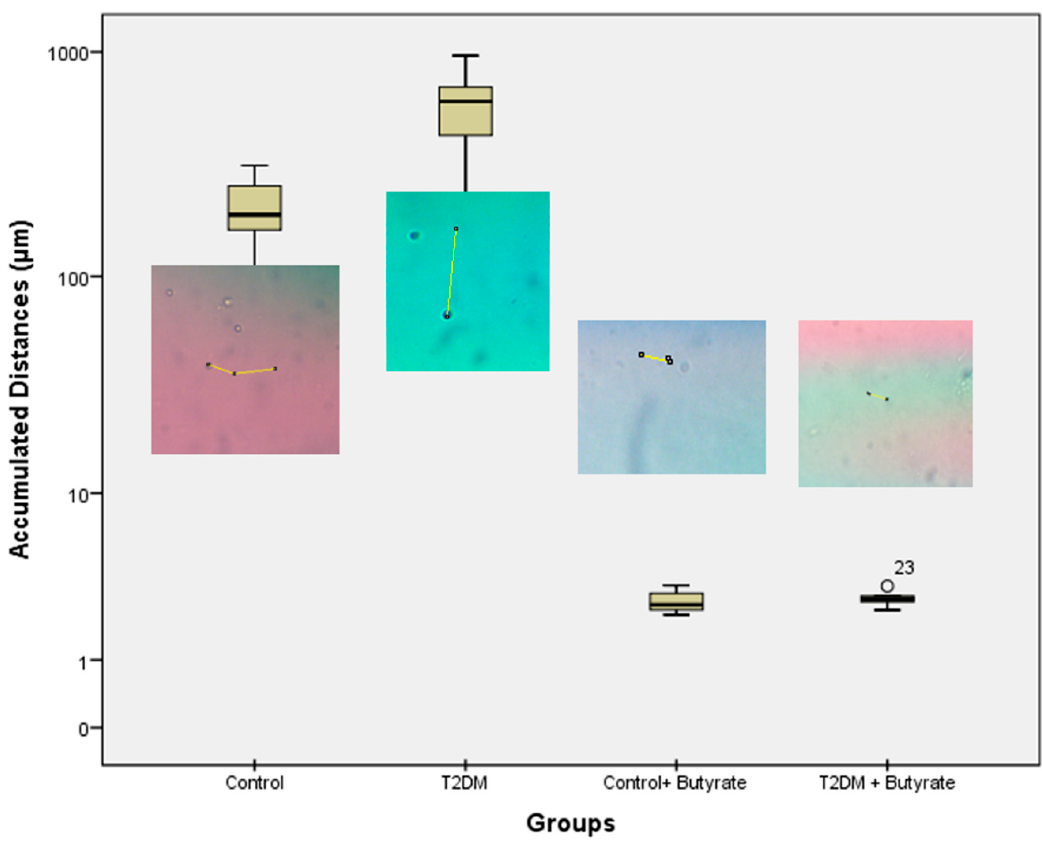
Figure 5. Monocyte migration after butyrate treatment.